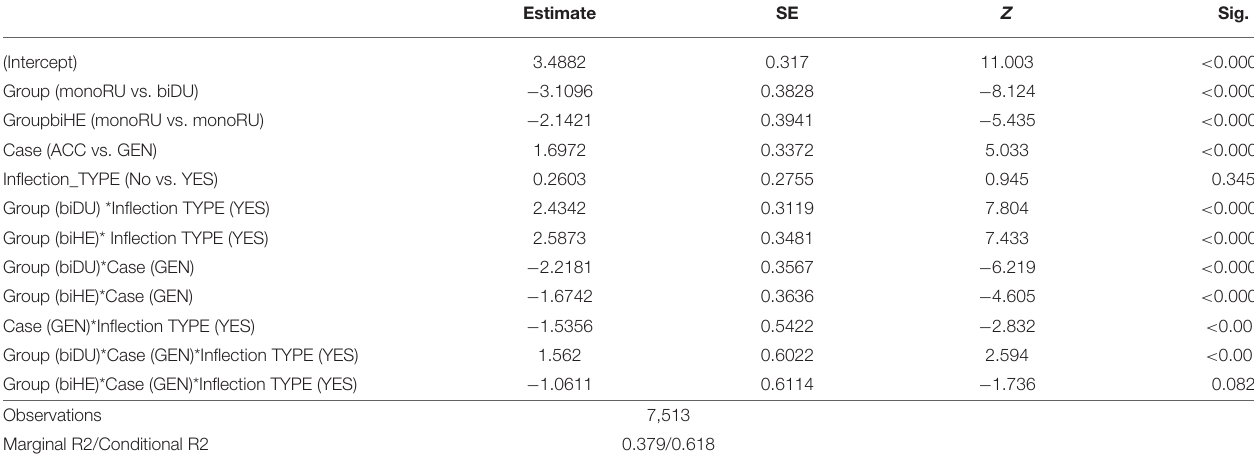
TABLE 3 | Model Summary for target case production for the child data. Estimate SE Z Sig.